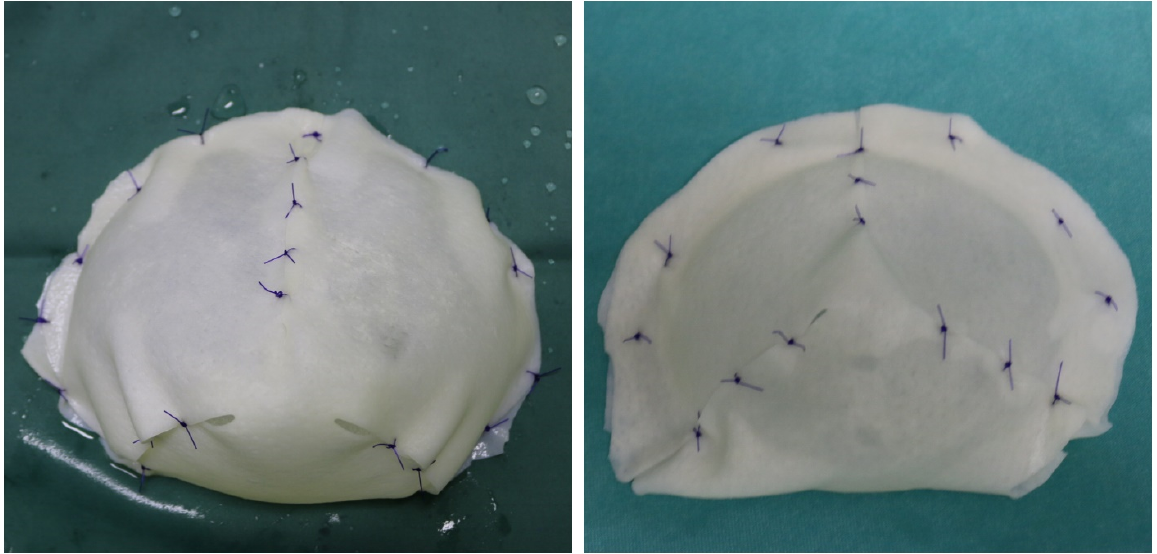
Figure 6. Pictures showing an example of total implant wrapping using ADM (acellular dermal matrix) from Dr. Cuomo’s archive.